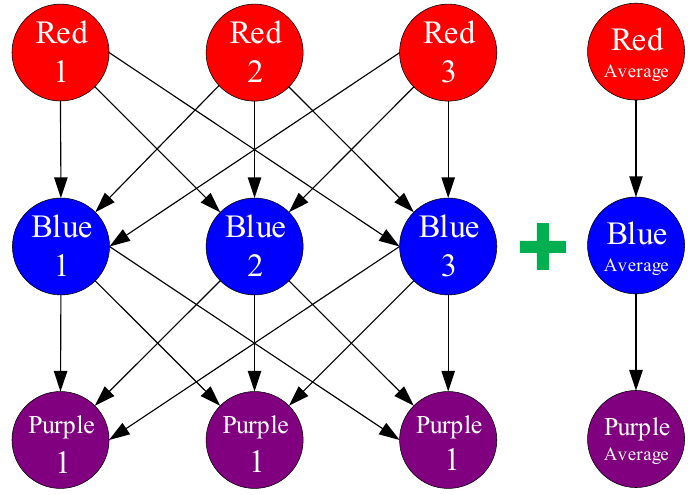
Figure 8. 28 groups of permutation for Red + Blue → Purple.